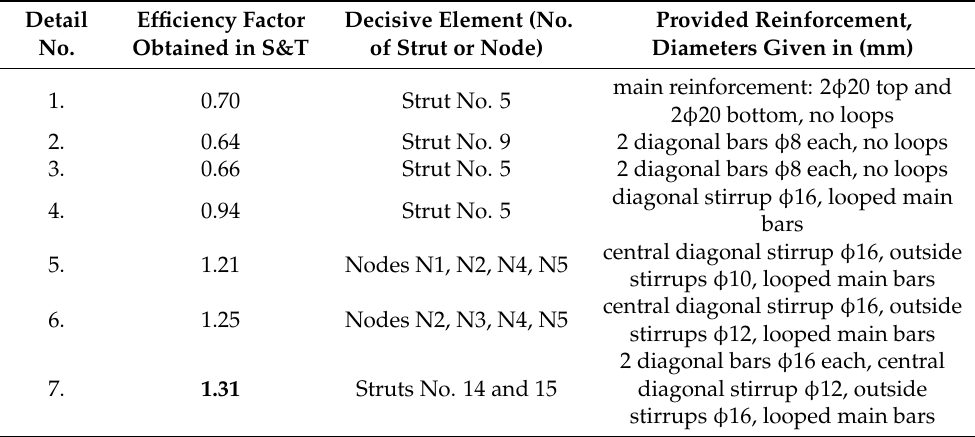
Figure 16. Truss schemes assumed for each reinforcement detail in the S&T method; dimensions in (mm). Table 4. Efficiency factors and provided reinforcement for each reinforcement detail—the case of elements with the same cross section heights (maximal value in bold). Detail No.